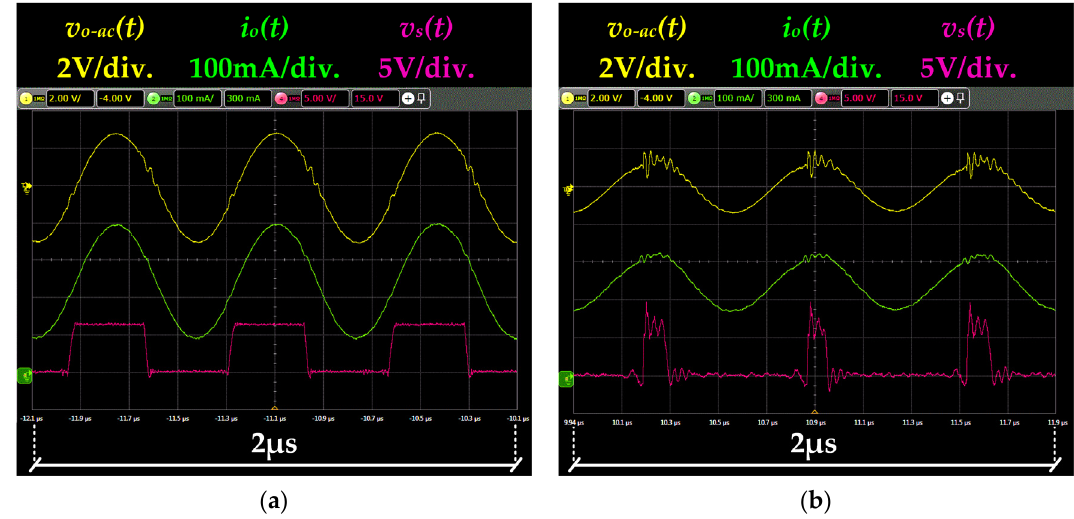
Figure 15. Main voltage and current waveforms under steady-state conditions ( a ) Results for d(t) = 0.5. ( b ) Results for d(t) = 0.2.